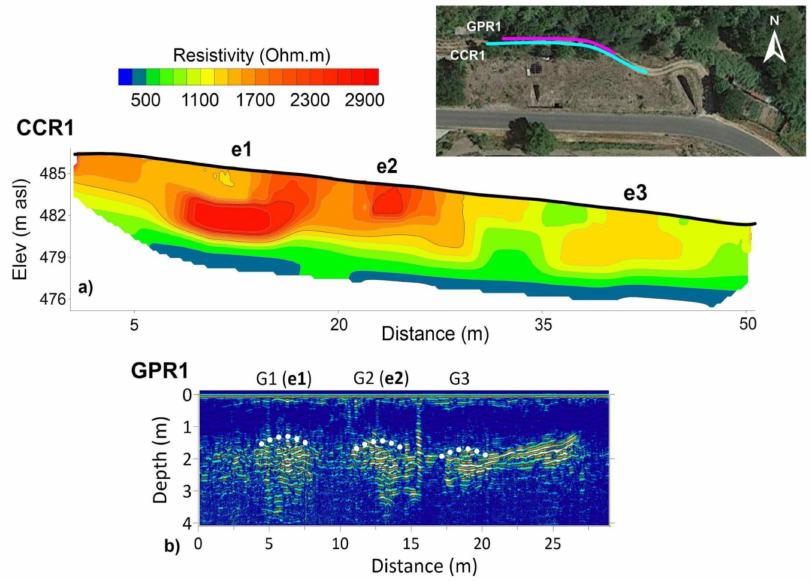
Figure 9. Geophysical data comparison. Comparison between ( a ) CCR2 resistivity model and ( b ) GPR1 radargram along the northwest-southeast oriented trail. Dashed white lines mark GPR anomalies attributed to the presence of partially filled voids.